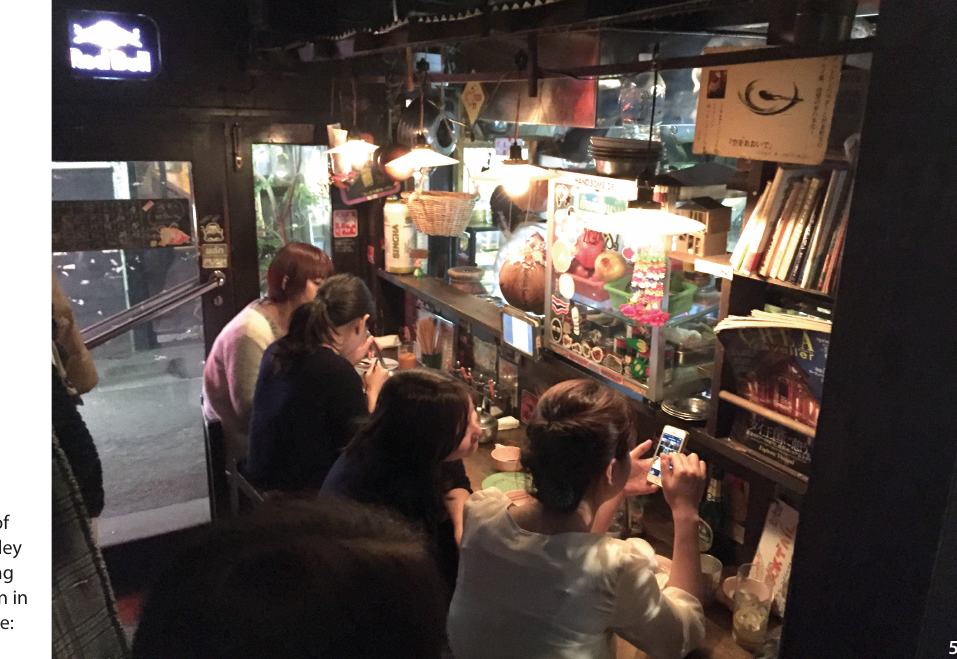
Figure 5 The narrow spaces of the bars on Tokyo’s Willow Alley makes communication among strangers more common than in larger nightlife spaces (Source: the